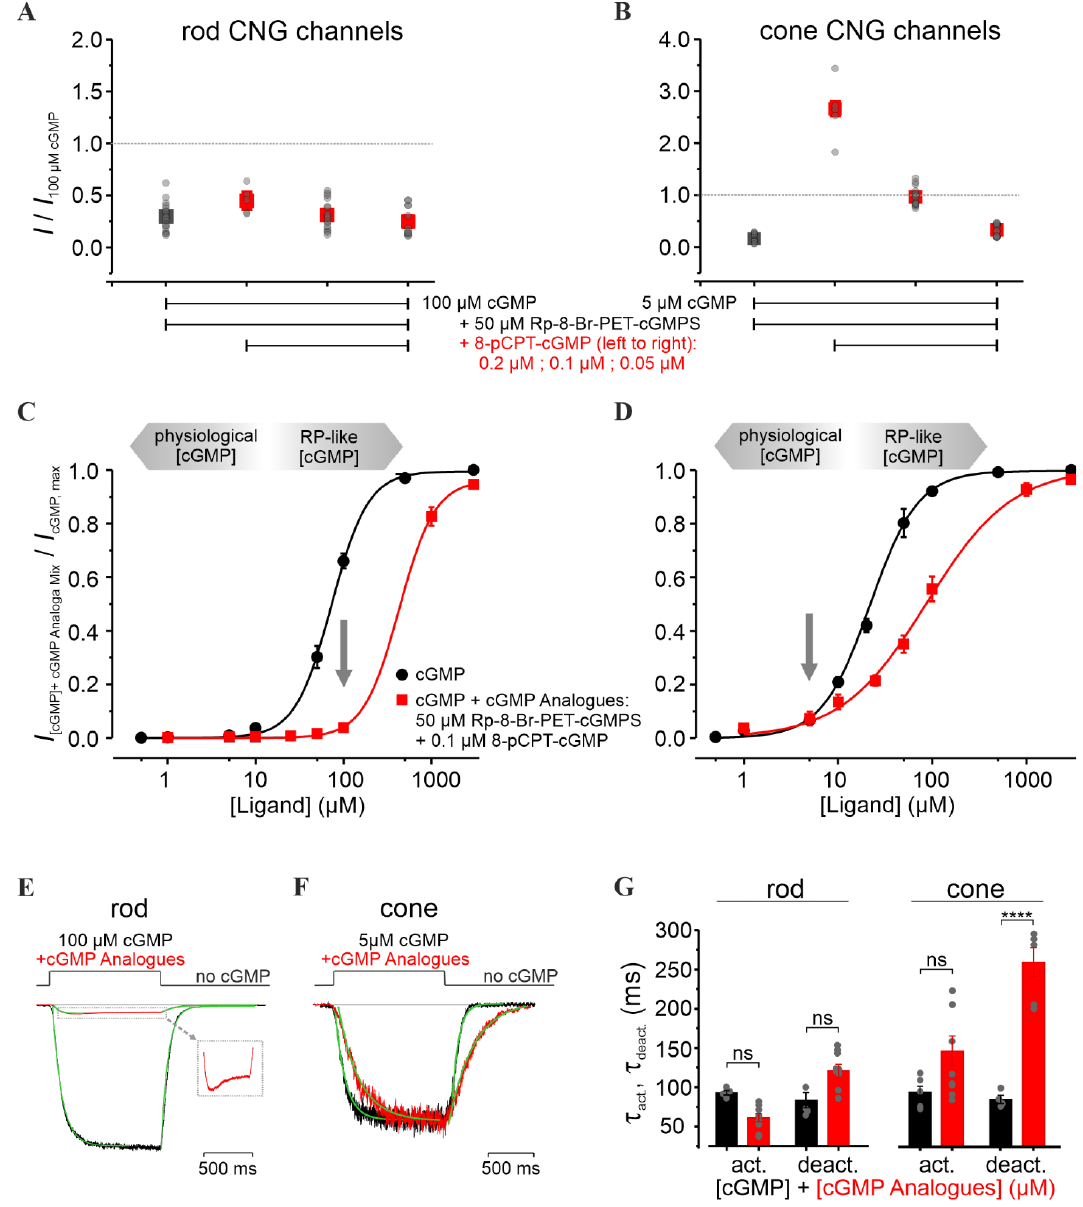
Figure 4. Influence of the combined cGMP-analogues treatment on retinal CNG channels. ( A , B ) Rela- tive current amplitudes of rod and cone CNG channels measured under steady-state conditions, in the presence of either cGMP + inhibitor (Rp-8-Br-PET-cGMPS, 50 µM, green) or cGMP + inhibitor (50 µM) + activator (8-pCPT-cGMP, 0.2 µM, 0.1 µM, and 0.05 µM, red). The measured currents were